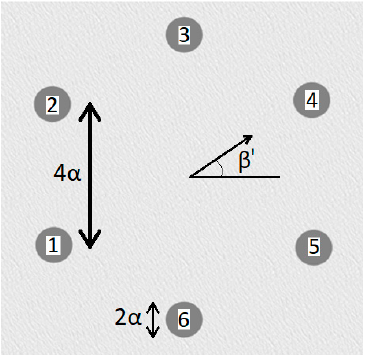
Figure 9. Arrangement and converters’ labels for a circular array of six WECs (wave energy con- verters).